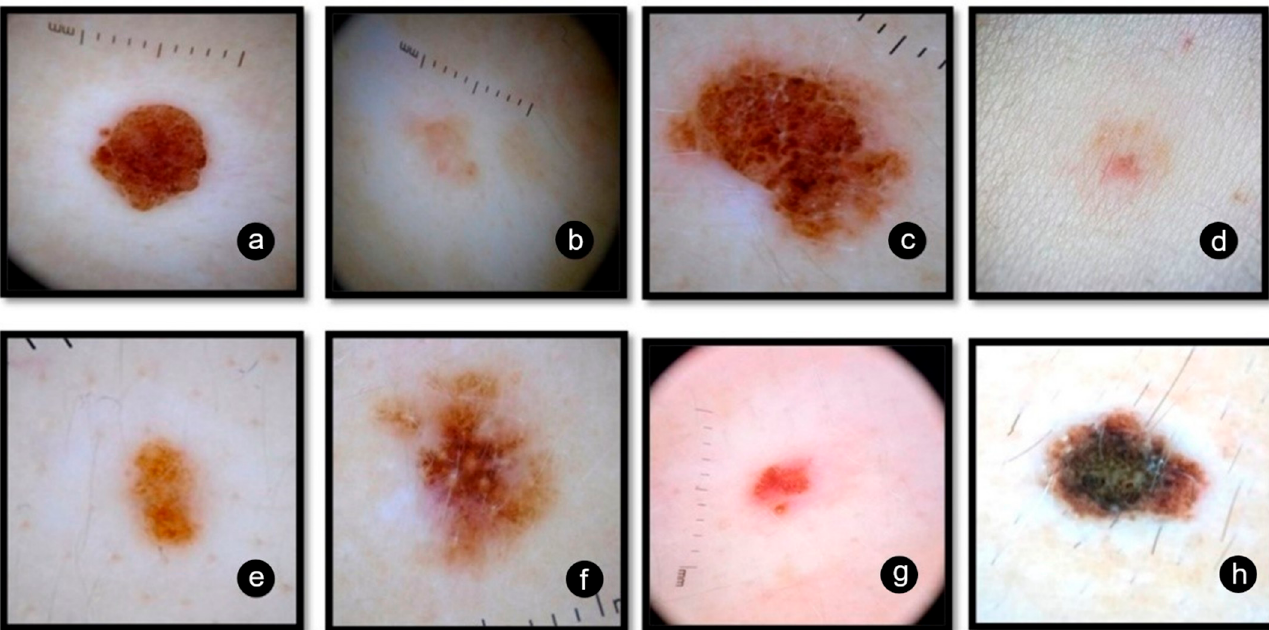
Figure 1. ( a ) Sutton nevus with symmetrical white rim; ( b ) Sutton nevus with asymmetrical white rim; ( c ) Sutton nevus with regional white patch; ( d ) Sutton nevus with no depigmentation area; ( e ) Complex pattern: reticulo ‐ globular; ( f ) Complex pattern: globular ‐ homogeneous with blue white veil and peppering; ( g ) Homogeneous pattern with coma ‐ like vessels; ( h ) Multicomponent pattern: inverse network with peripheral globular ‐ homogeneous.